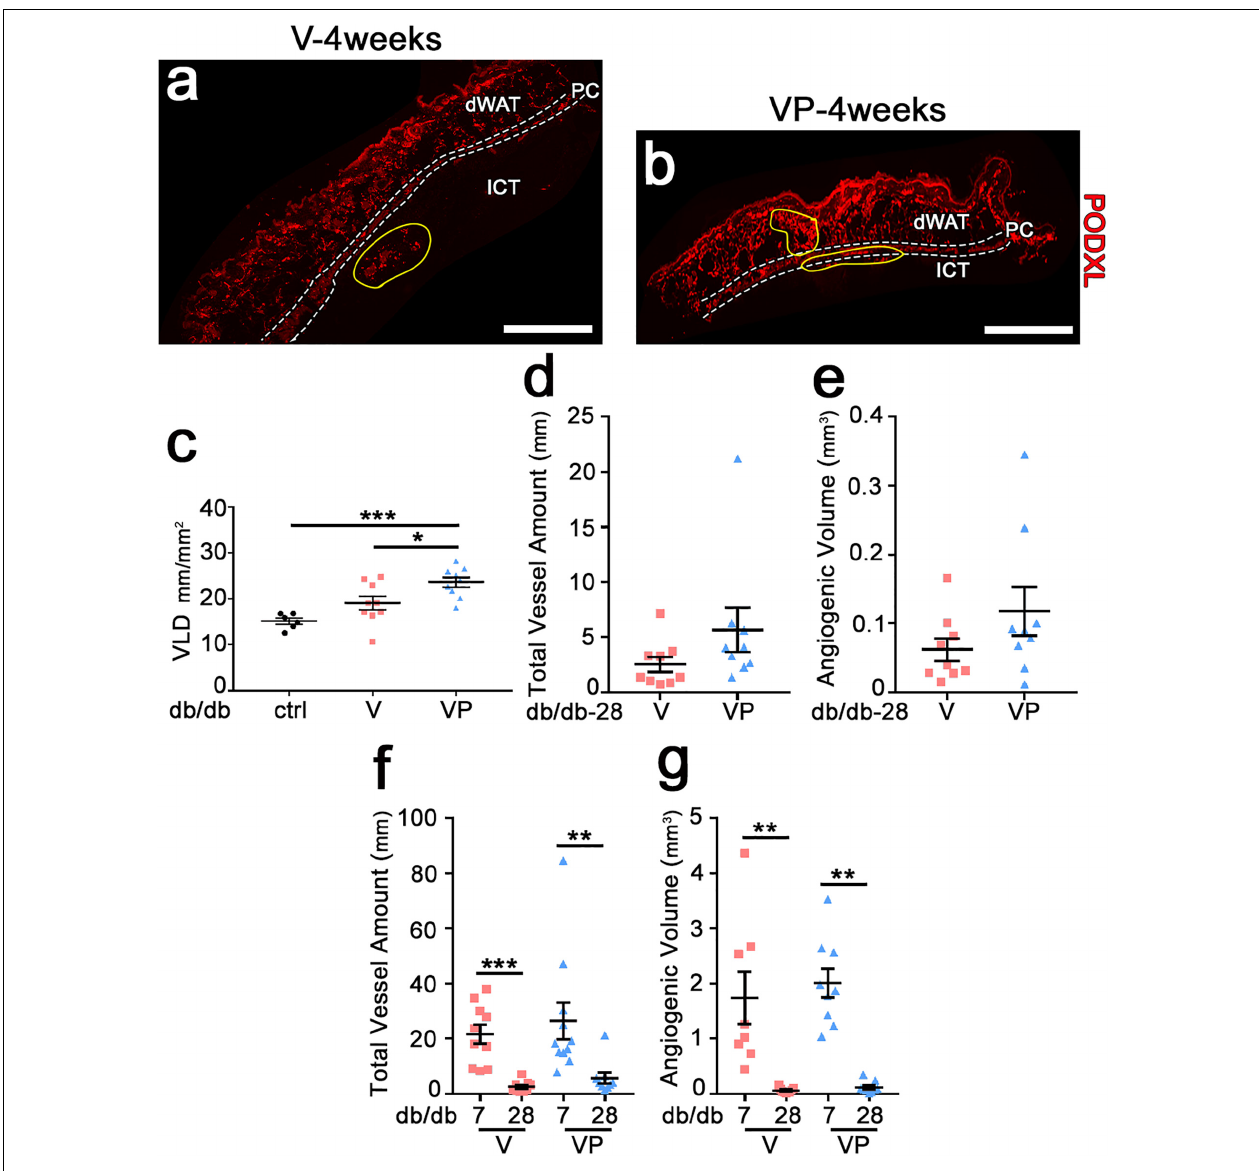
FIGURE 5 | Newly induced angiogenesis is transient in diabetic skin. (a,b) Immunostaining with antibodies against podocalyxin (endothelial cells, red) was performed on cryosections of dorsal skin of diabetic mice 4 weeks after implantation of V, VP or control (ctrl) empty gels; dWAT, dermal adipose white tissue; PC, panniculus carnosus; ICT, interstitial connective tissue. Angiogenic areas are marked in yellow. (c) Vascular density in visible angiogenic areas was quantified by measuring VLD. Data are shown as mean values of each sample ± SEM ( n = 6–9 samples/group); * p < 0.05, *** p < 0.001 by 1-way ANOVA with Tukey multiple comparisons test. (d,f) Total vessel amount in angiogenic areas after 4 weeks (d) and in comparison with the 7-day time-point (f) . (e,g) Total angiogenic volume after 4 weeks (e) and in comparison with the 7-day time-point (g) . Data represent mean values of each sample ± SEM ( n = 8–11 samples/group). ** p < 0.01, *** p < 0.001 by Kruskal–Wallis test. Scale bars = 1 mm in all